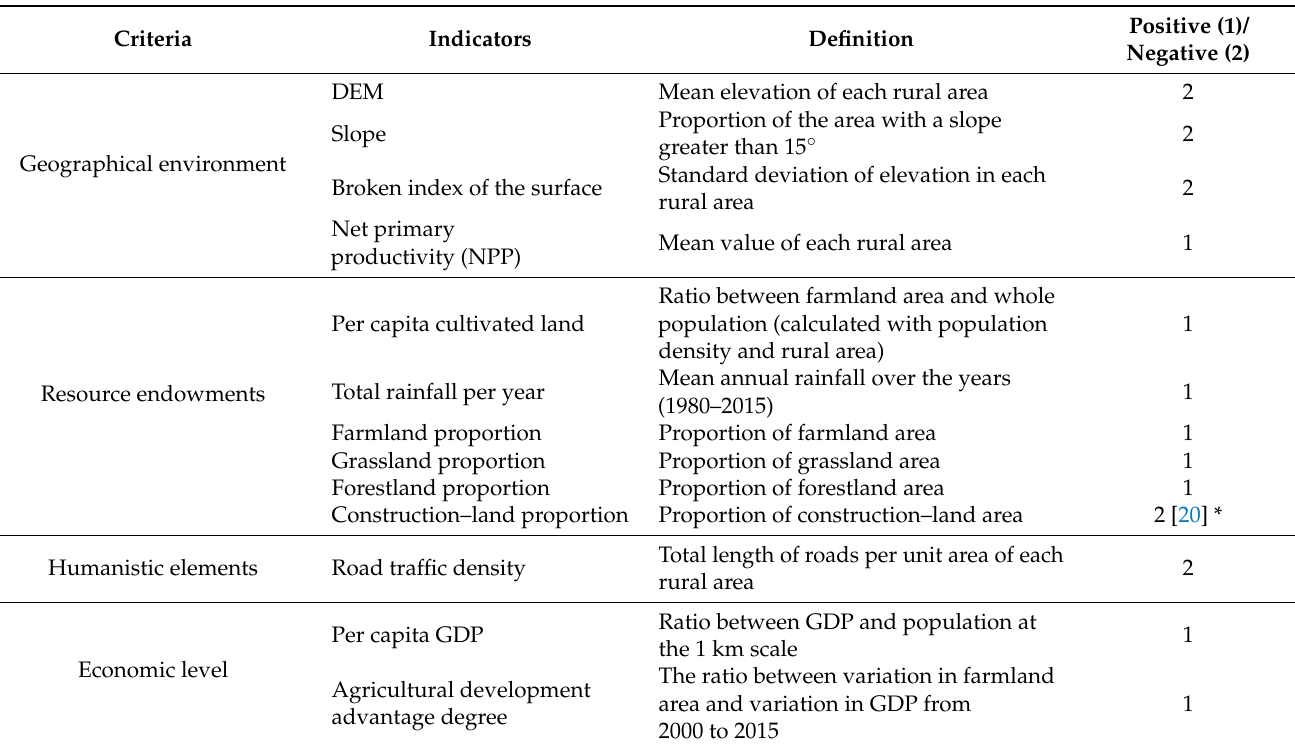
Table 3. Index system built during dataset